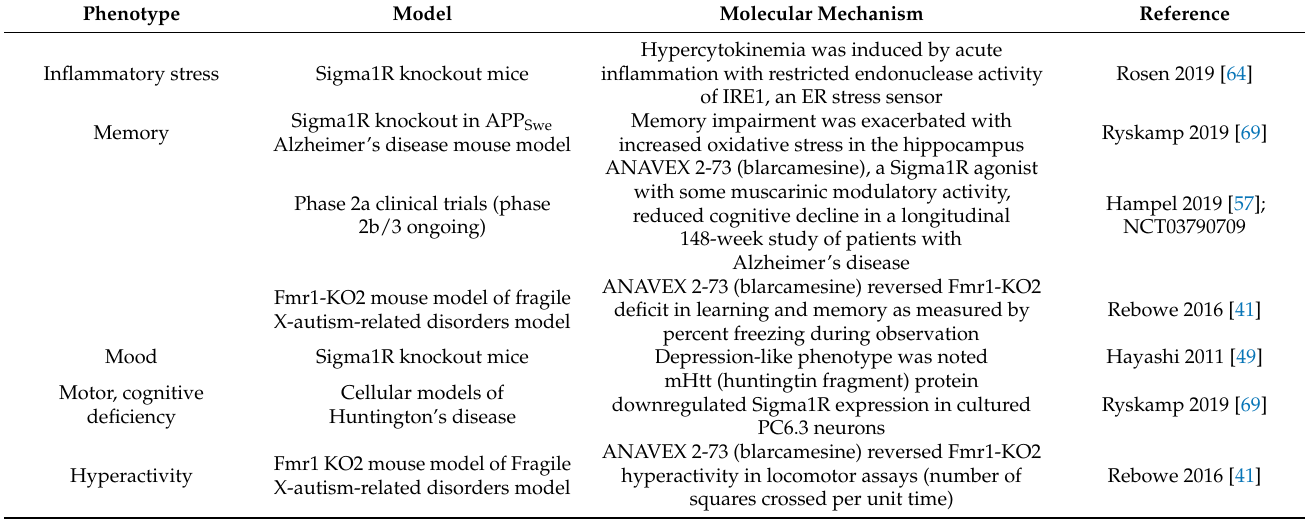
Table 3. Non-seizure DEE-like phenotypes associated with Sigma1R genetic deficiency models or genetic linkage analyses in other